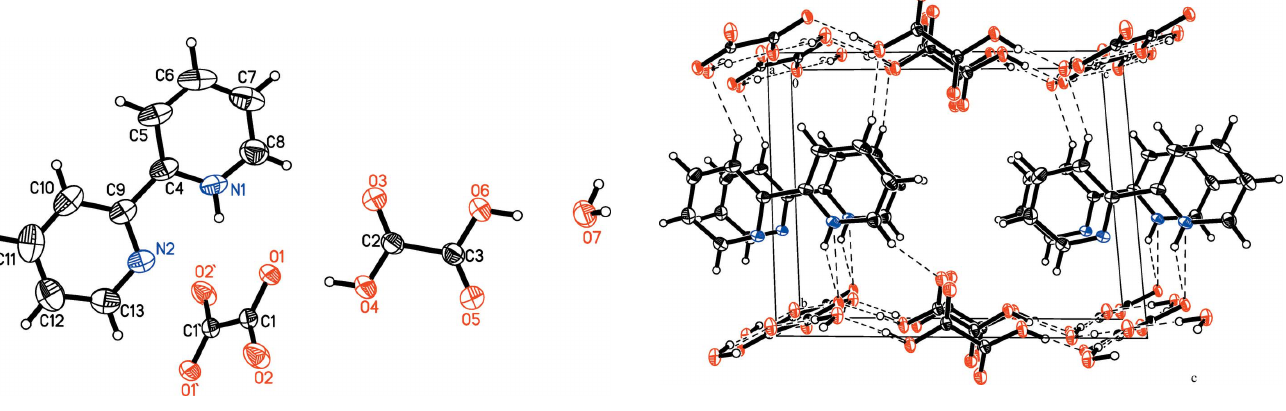
Figure 1 The molecular structure of the title compound with displacement ellipsoids drawn at the 50% probability